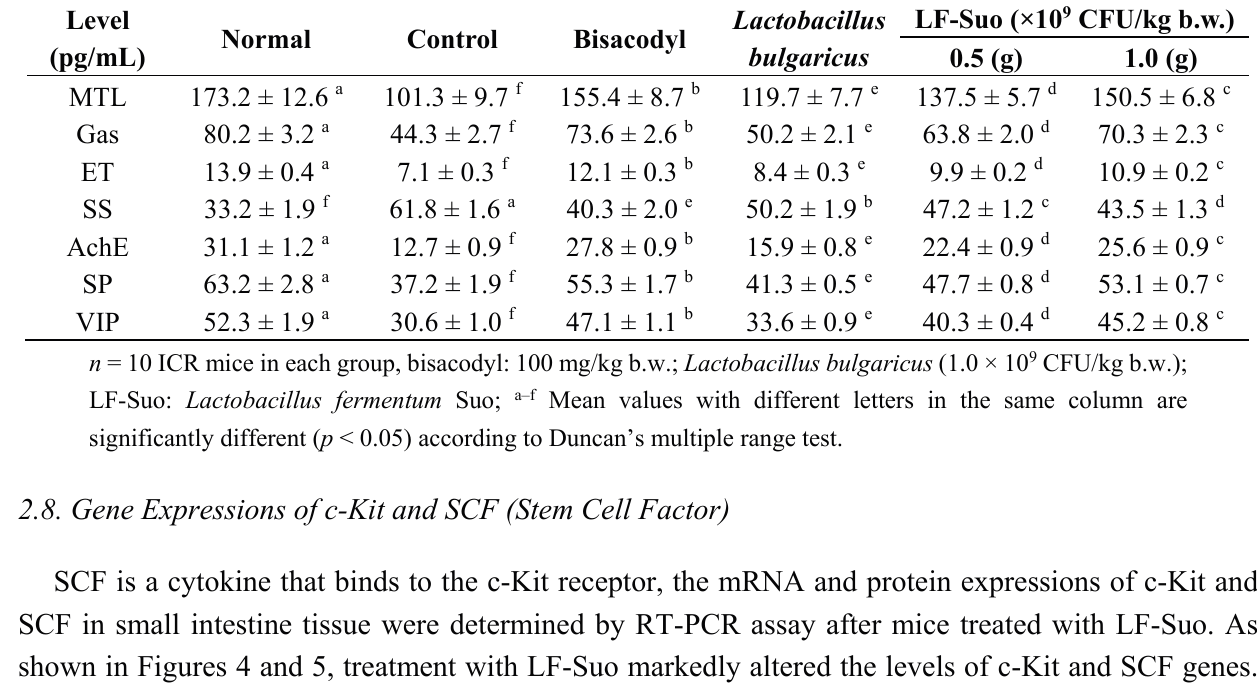
Table 6. Effect of various samples on serum MTL (motilin), Gas (gastrin), ET (endothelin), SS (somatostatin), AchE (acetylcholine enzyme), SP (substance P) and VIP (vasoactive intestinal peptide) levels in activated carbon-induced constipation model